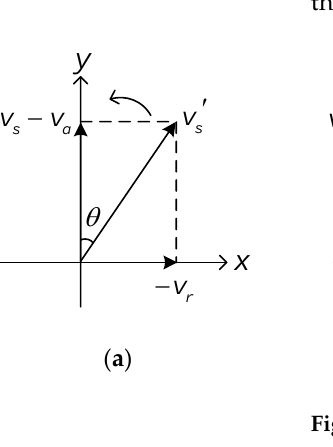
Figure 4. Relative speed’s four cases due to speed difference. ( a ) v s − v a > 0, v r < 0. ( b ) v s − v a > 0, v r > 0. ( c ) v s − v a < 0, v r > 0. ( d ) v s − v a < 0, v r <